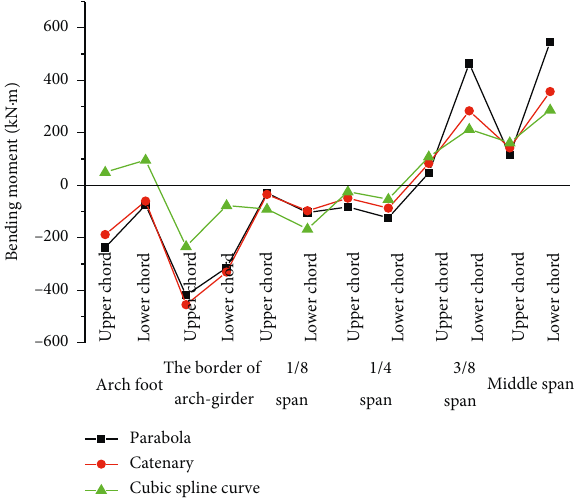
Figure 10: Bending moment of the six key sections.